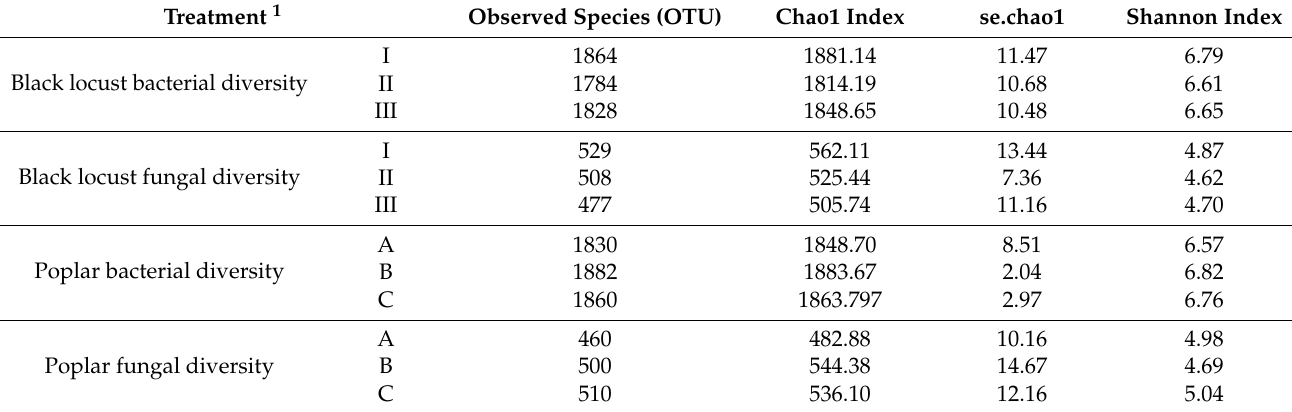
Figure 4. The relative abundance of top 10 fungal phyla in the soil of black locust and poplar plantation by treatments; control (I—black locust; A—poplar), fertilizer (II—black locust; B—poplar) and arbuscular mycorrhizal (III—black locust) and ectomycorrhizal (C—poplar) treatment. The highest bacterial and fungal species richness was observed in the rhizosphere soil of control treatment in black locust plantation (1881.14 and 562.11, based on Chao1 index). The control soil of black locust plantation had the highest diversity (Shannon’s diversity range at 6.79), while the fertilizer treatment had the lowest bacterial species richness and diversity. For the poplar plantation, the bacterial and fungal community richness and bacterial diversity increased in soil of fertilizer treatment. The fungal diversity in rhizosphere soil of ectomycorrhizal treatment was the highest in poplar plantations (Table 1). Table 1. α -diversity of bacterial and fungal community in rhizosphere soil of black locust and poplar plantations. Treatment